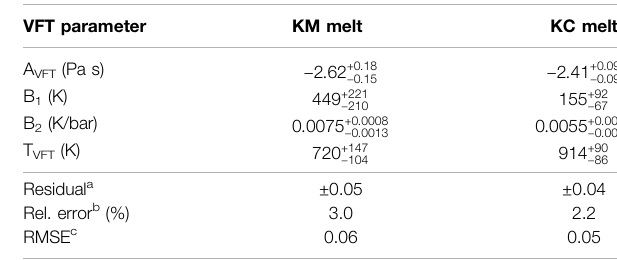
TABLE 3 | Best- fi t parameters for the Vogel-Fulcher-Tammann (VFT) model [ Eq. 6 ] fi tted to the pressure-temperature dependence of the viscosity